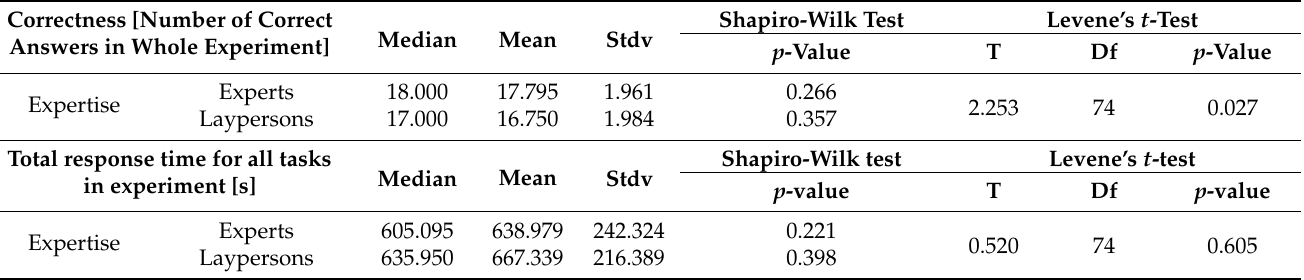
Table 7. The overall measures (correctness and response time) and analyses report in terms of expertise